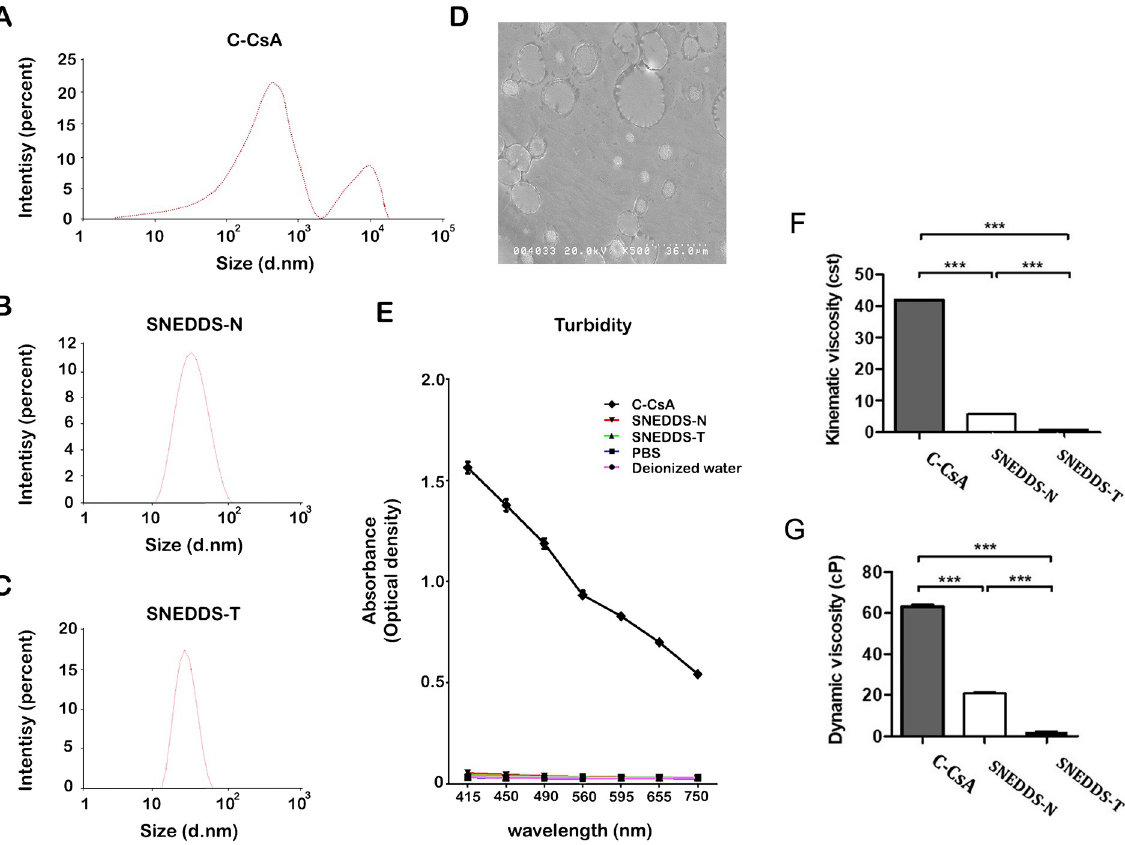
Fig 1. Size distribution (percent) of CsA emulsions by intensity: (A) Restasis (C-CsA), (B) T-sporin (SNEDDS-T) and (C) Cyporin-N (SNEDDS-N). (D) Scanning electron microscope (SEM) evaluation of C-CsA. (E) Turbidity (optical density) of CsA emulsions.